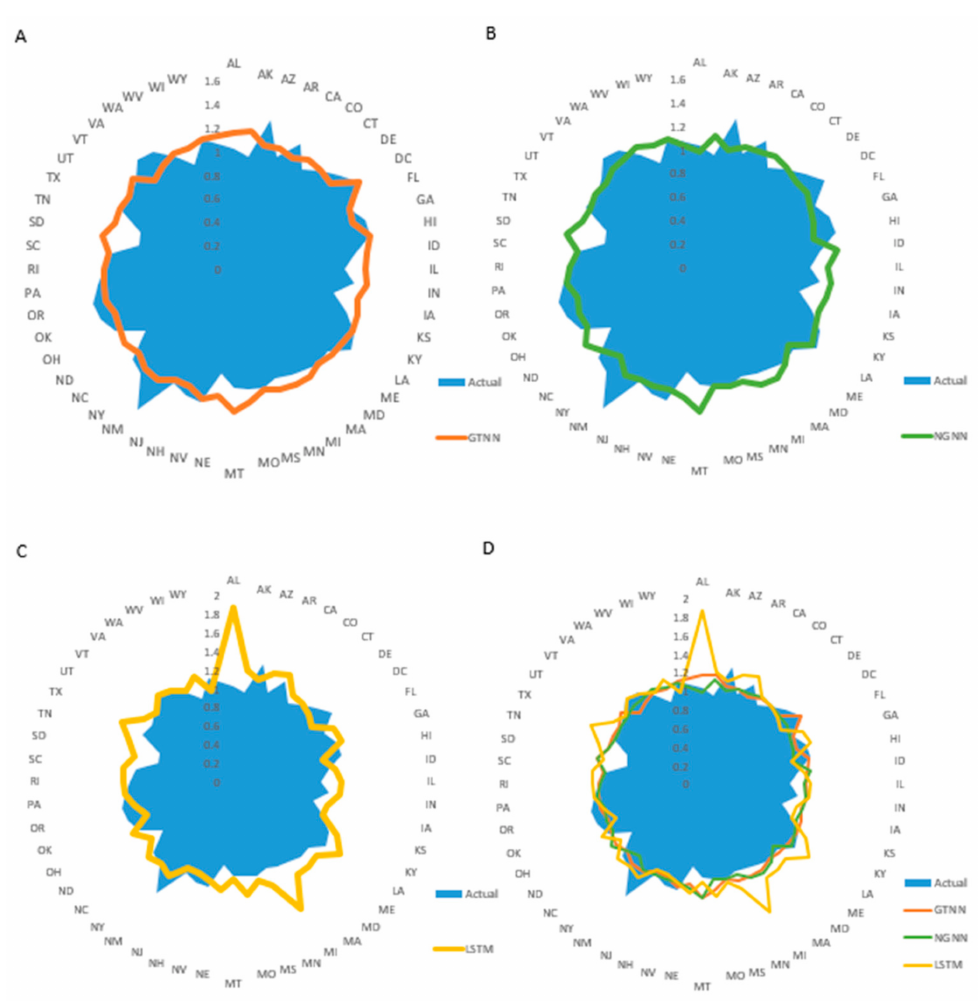
Figure 7. Actual and predicted values for R t for all states on 23 November 2020. Shown are values predicted using the GTNN ( A ), NGNN ( B ), and LSTM ( C ) models. Superimposed results from all models are shown in ( D ).